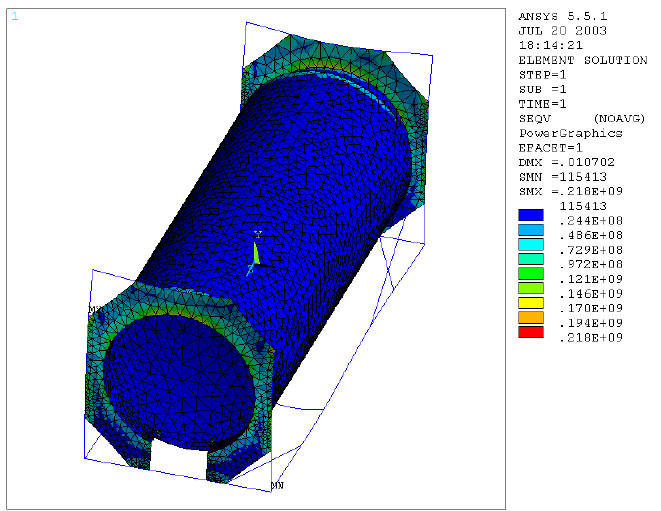
Figure 21. Maximum equivalent tension reducing the thickness of the plate and the skirt by 5 mm.